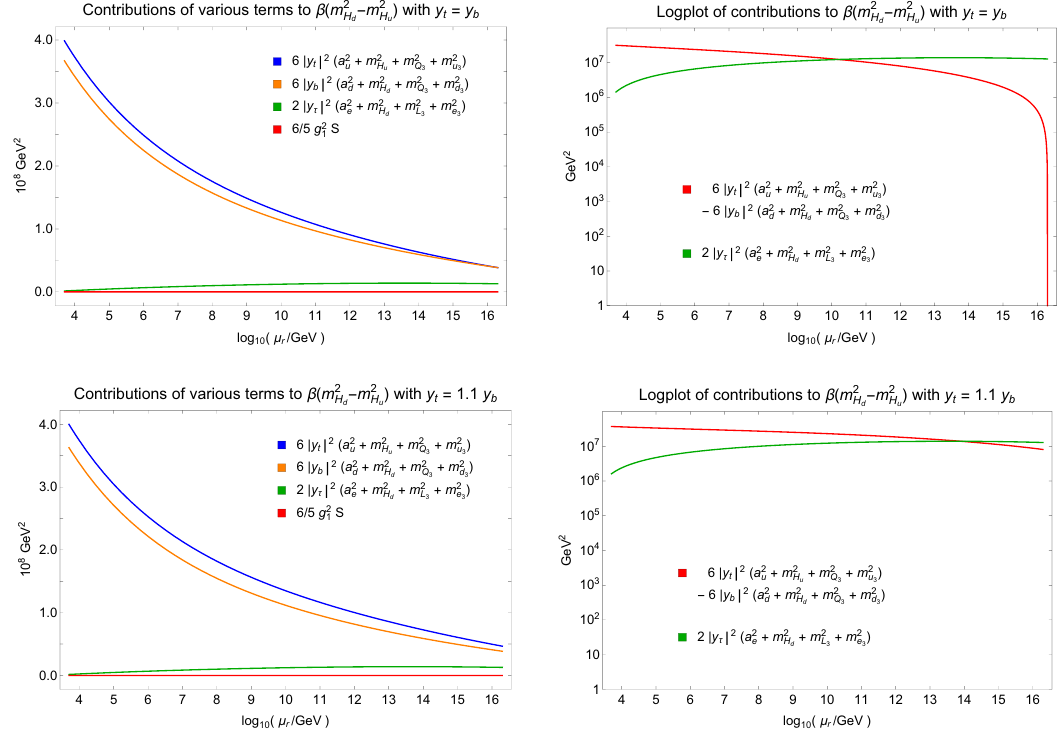
Figure 4 . The contributions of di(cid:11)erent terms to (cid:12) ( m 2 same contributions in a logplot (right). The plots are drawn for the case y t = y b (above), and a deviation from that with y t = 1 : 1 y b